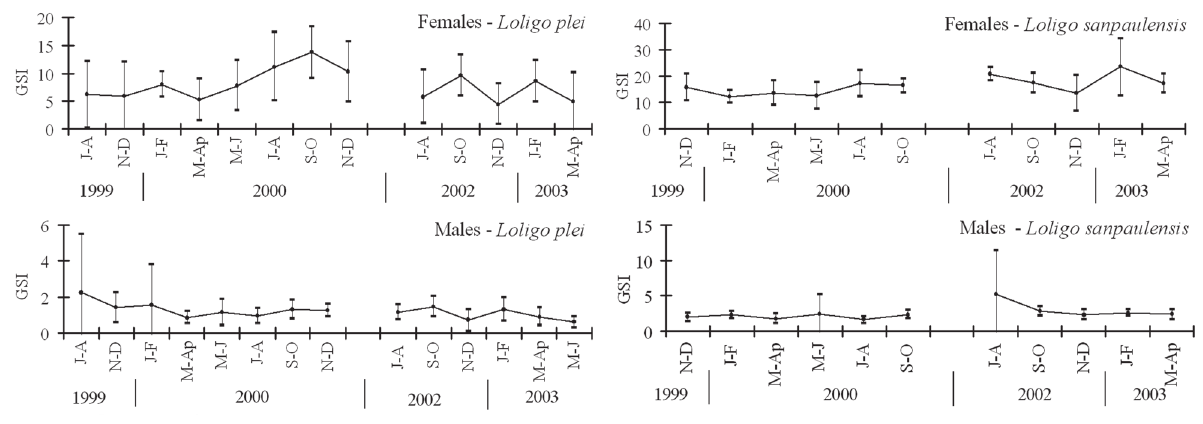
Fig. 8 . – Bimonthly variation of the mean GSI with standard deviation for females and males of L. plei and L. sanpaulensis .